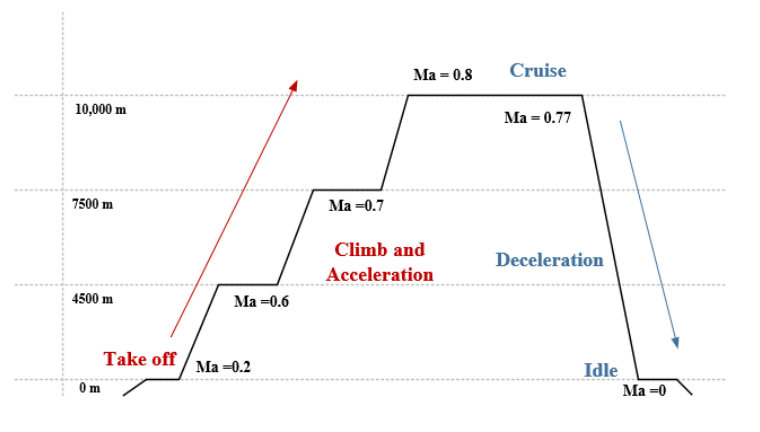
Figure 6. Schematic curve of altitude and Mach number.